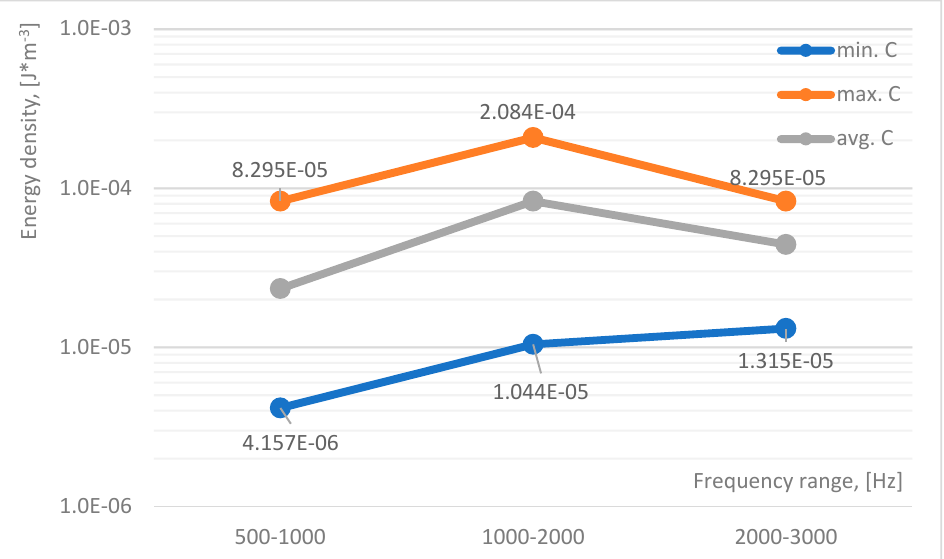
Figure 17. The average value of the total acoustic wave energy density for the curved track at a speed of 200 km/h.